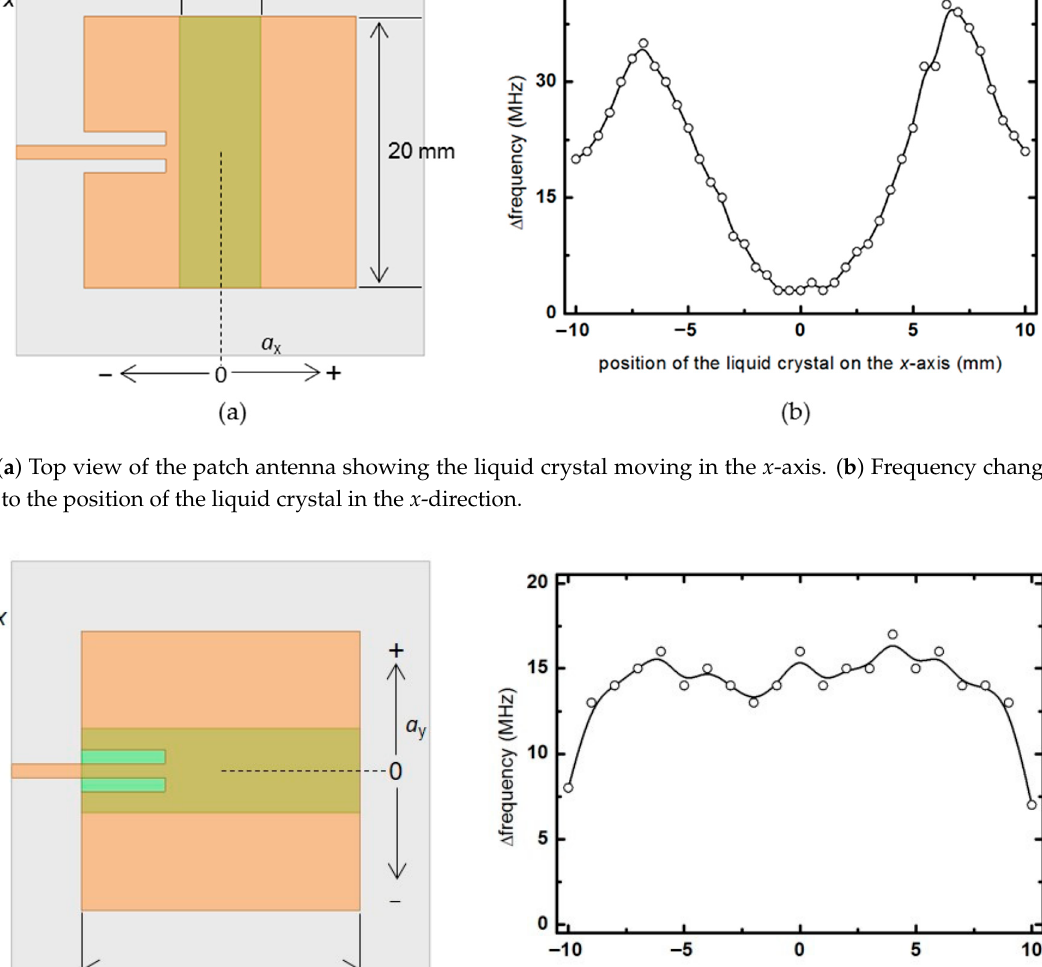
Figure 6. ( a ) Top view of the patch antenna showing the liquid crystal moving in the x -axis. ( b ) Frequency change rate according to the position of the liquid crystal in the x -direction.